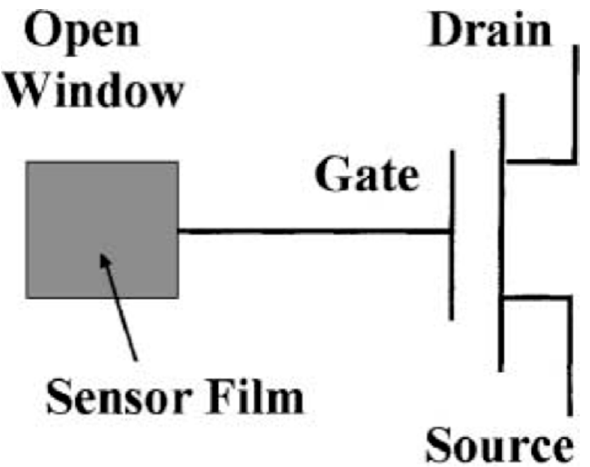
Figure 7. Integral diagram of the discrete ISFET. Reprinted with permission from Ref. [90]. (Copyright, 2001, Elsevier).